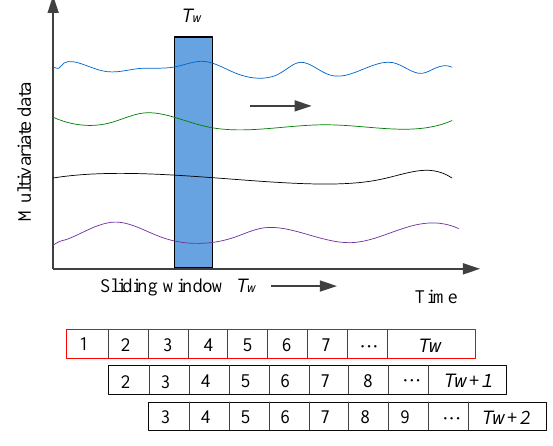
Figure 14. Sliding time window.